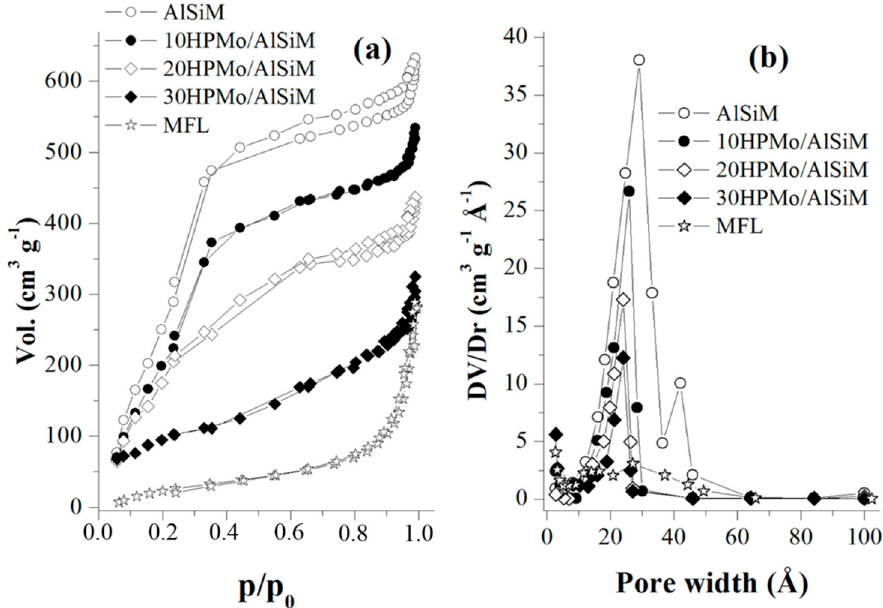
Figure 3. Nitrogen physisorption isotherms ( a ) and pore distribution. ( b ) of samples AlSiM and (10, 20, 30) HPMo/AlSiM.